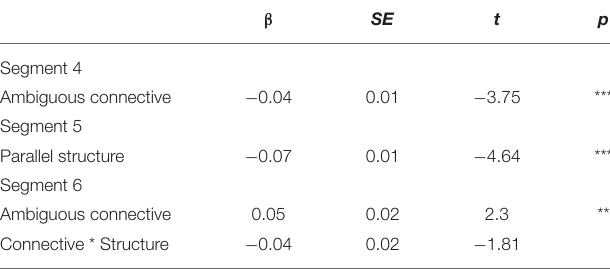
TABLE 8 | Model of the L1 data on segments 4, 5, and 6 (Experiment 3).